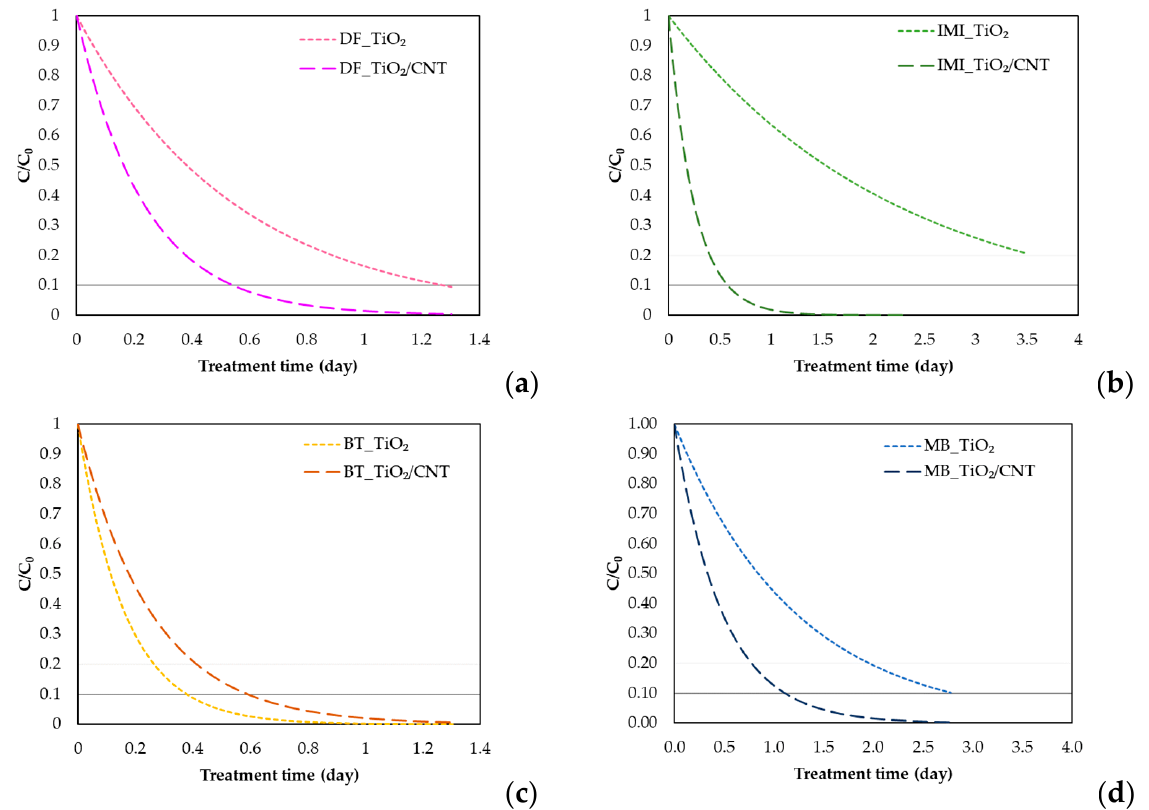
Figure 6. Modeled photocatalytic degradation on TiO 2 and TiO 2 /CNT over period of time to achieve 90% efficiency of: ( a ) diclofenac (DF), ( b ) imidacloprid (IMI), ( c ) 1H-benzotriazole (BT), ( d ) methylene blue (MB).